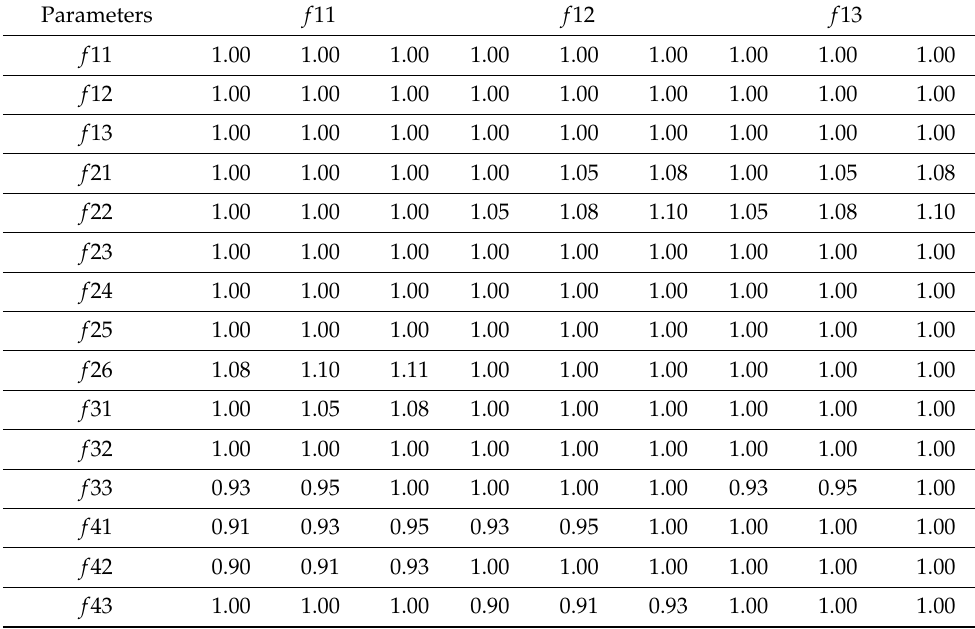
Table A1. Fuzzy logic combined judgement matrix of 15 criteria.